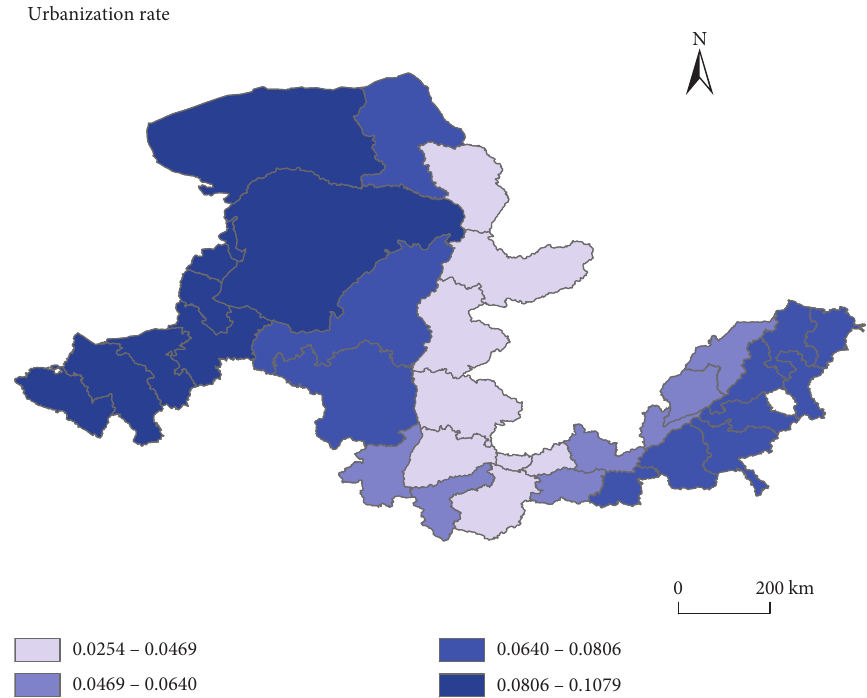
Figure 5: Spatial distribution of the coefficient of urbanization rate to